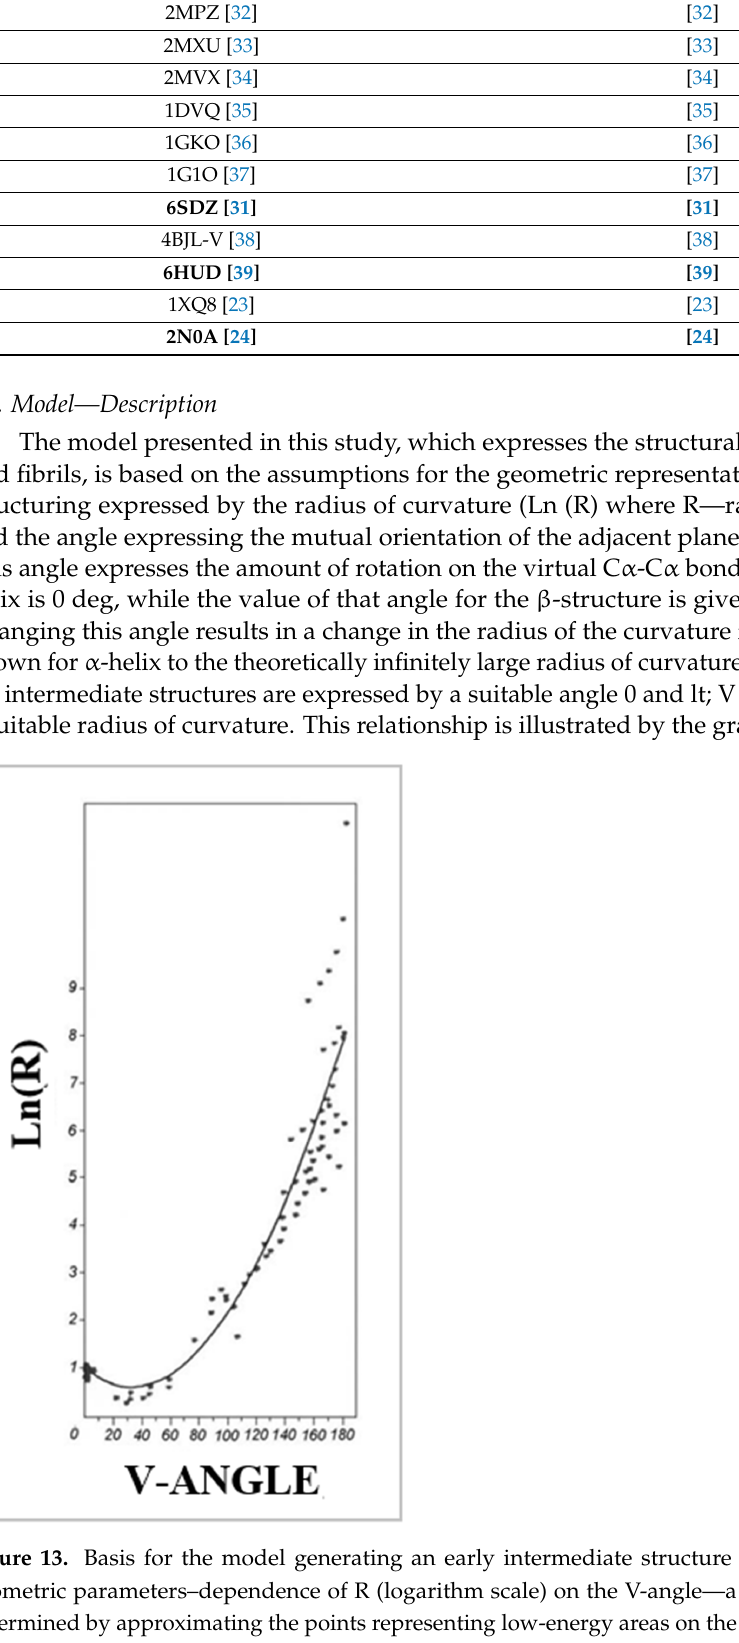
Figure 14. Distribution of the values of geometric parameters describing the polypeptide arrange ‐ ment: ( A )—radius of curvature on the Ln (R) scale; ( B )—V ‐ angle—angle expressing the relative